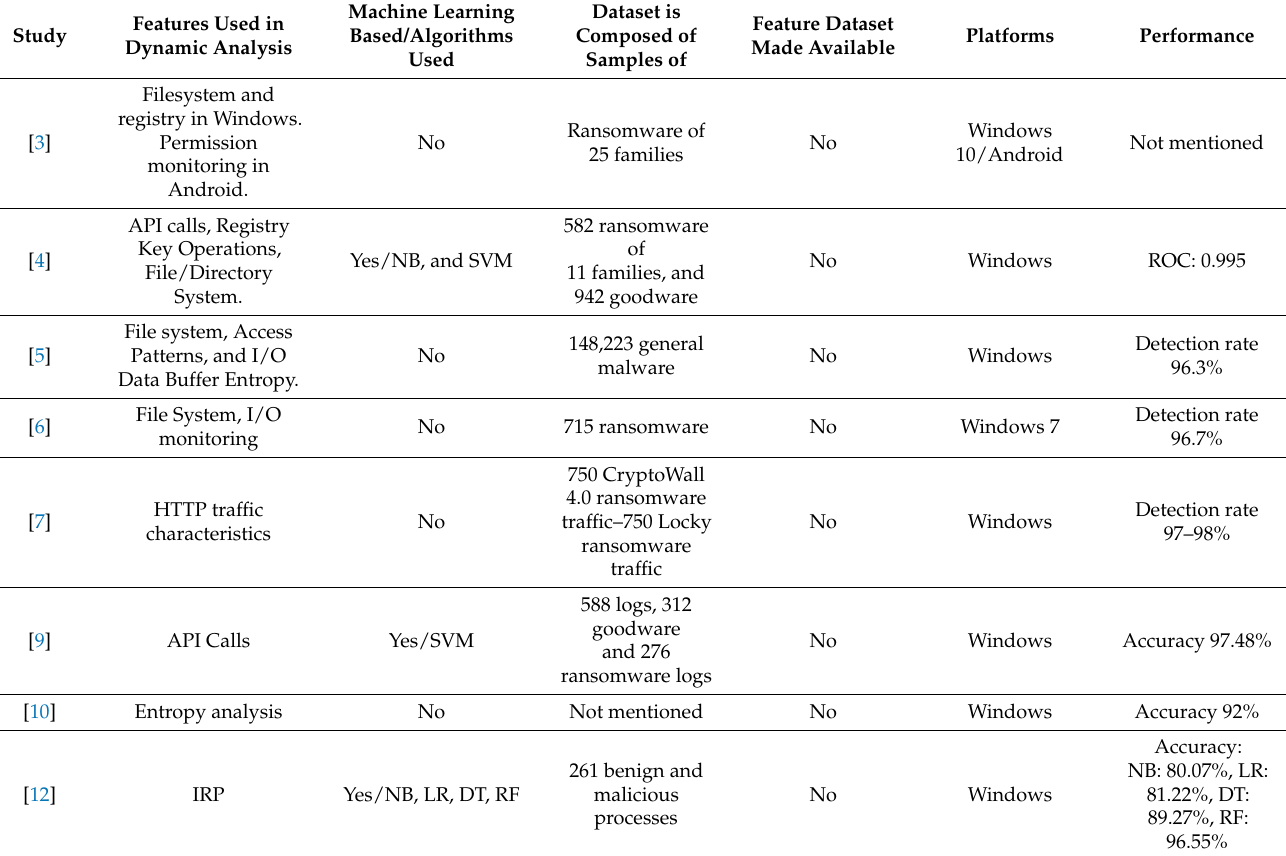
Table 1. Characteristics of dynamic analysis